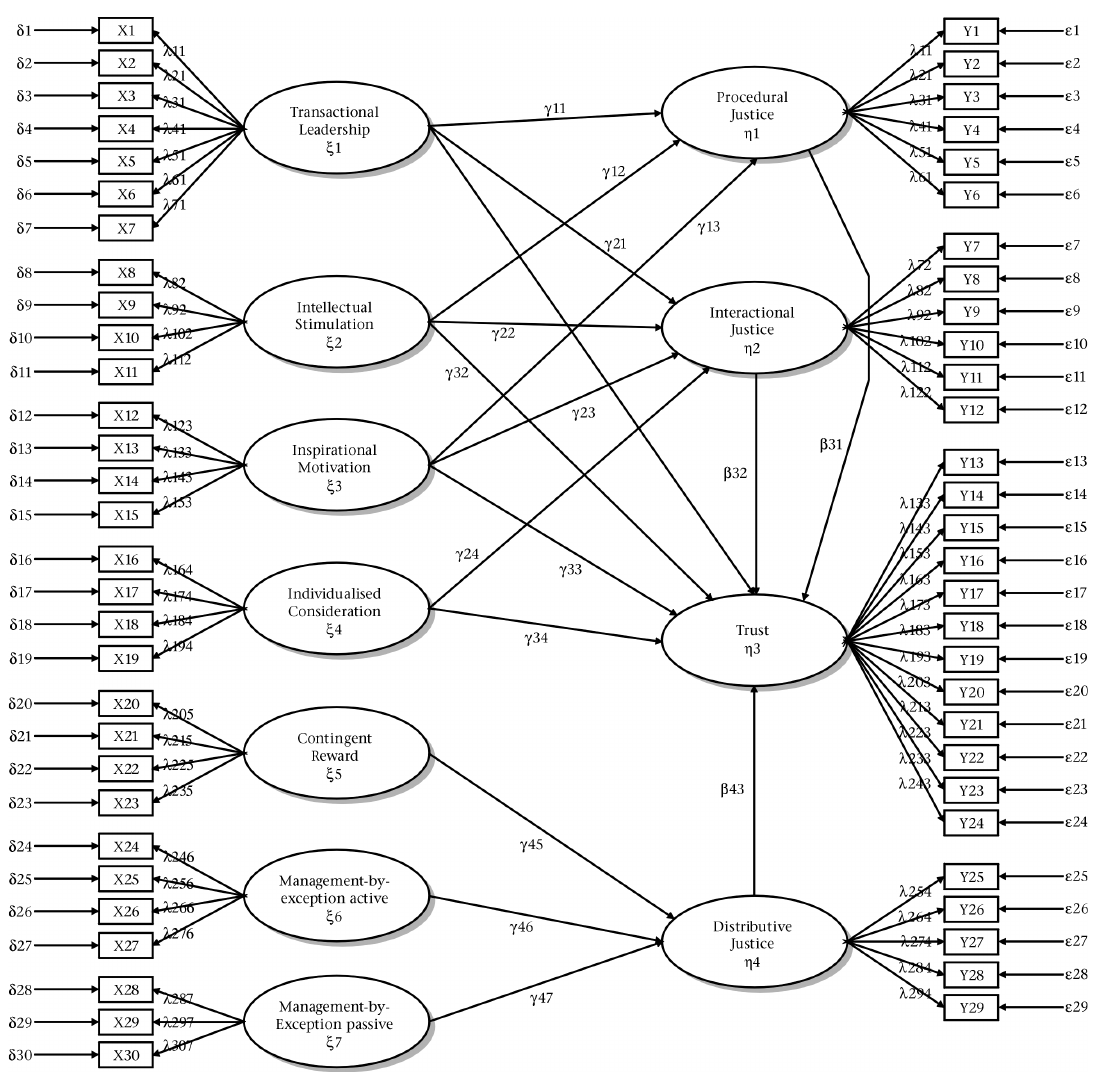
Figure 2: LISREL path